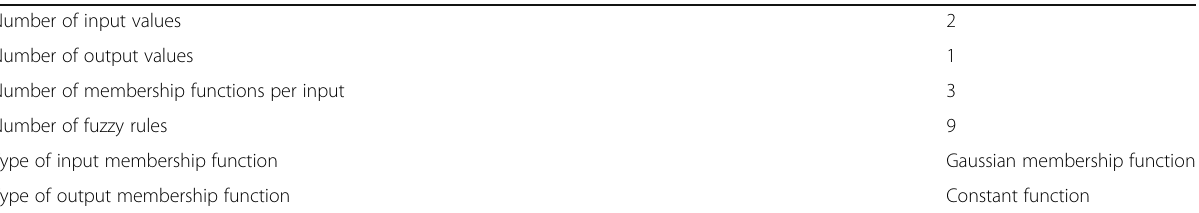
Table 2 The ANFIS properties of the proposed scheme